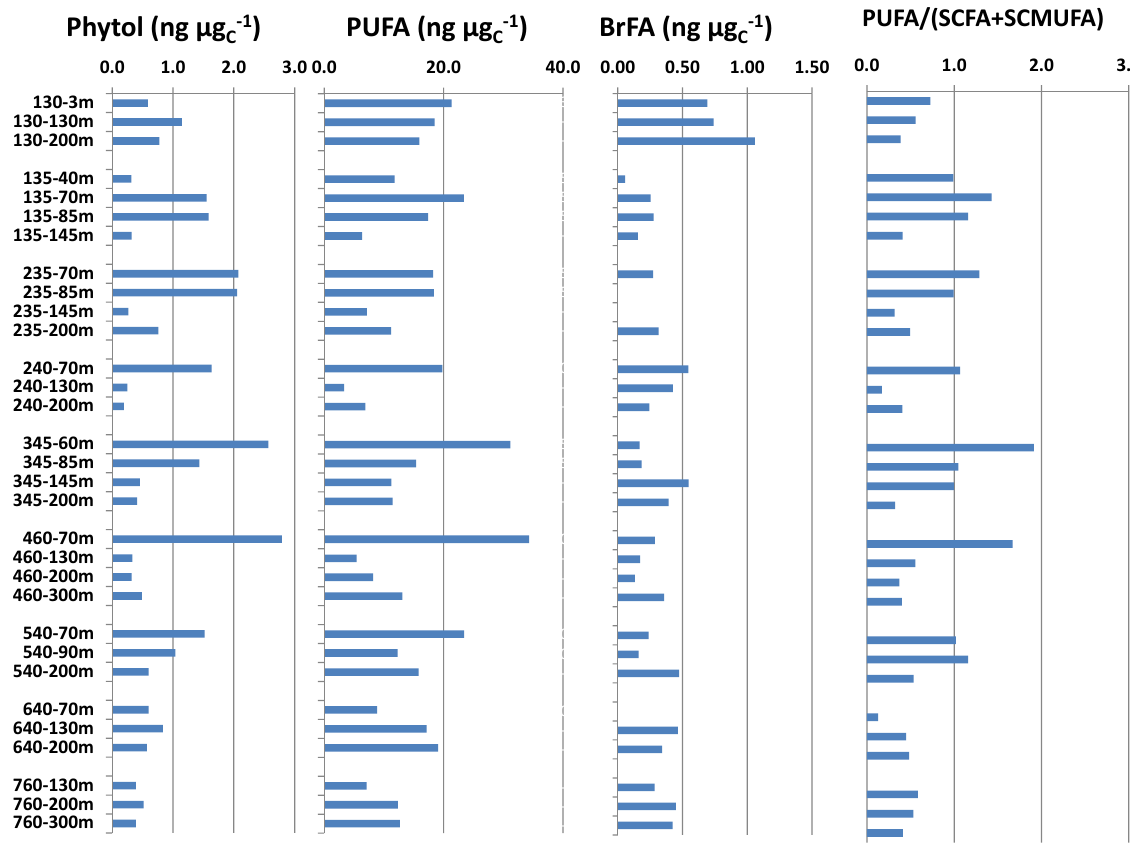
Fig. 10. Concentrations normalized to TOC of selected lipid biomarkers and diagnostic ratios in the SPM of offshore open waters ( > 200m depth) from the Mackenzie